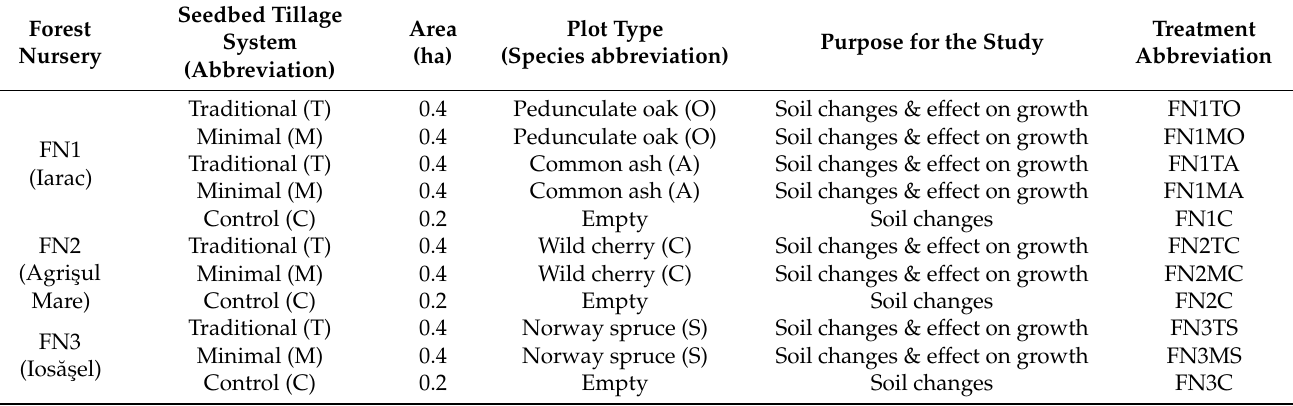
Table 3. Description of experimental layout for comparing the effect of the seedbed tillage system on seedling growth at species